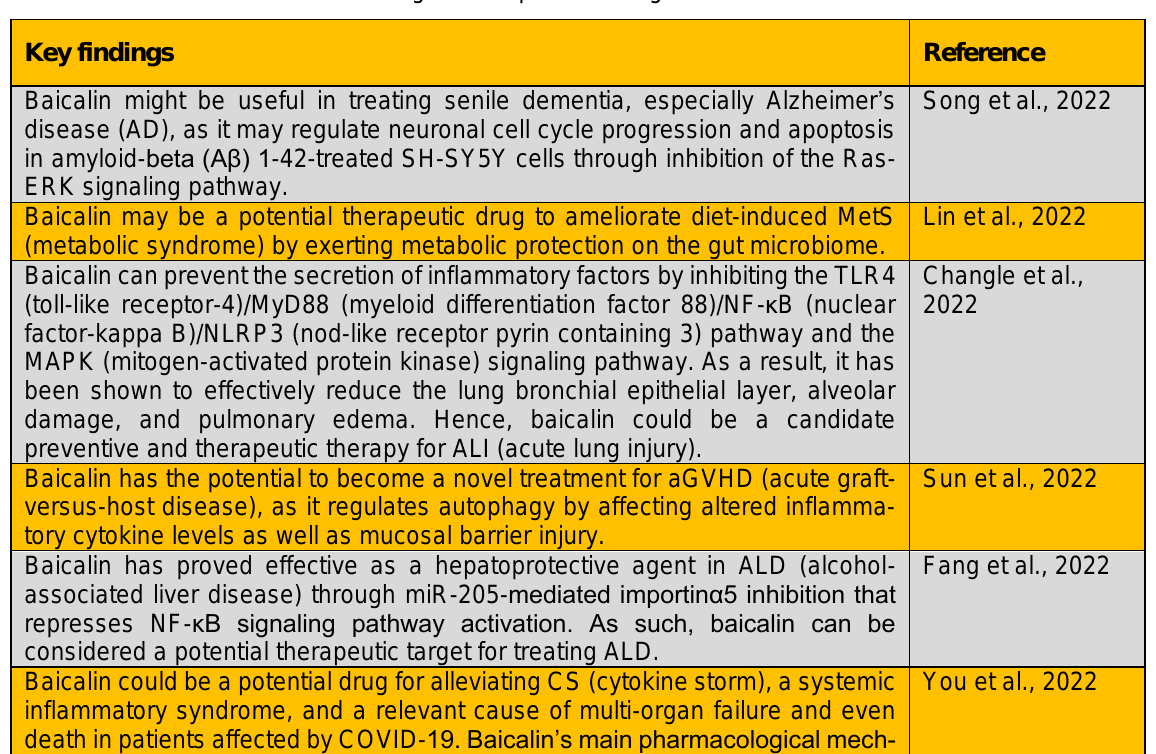
Table 1: Recent studies on the biological and pharmacological activities of